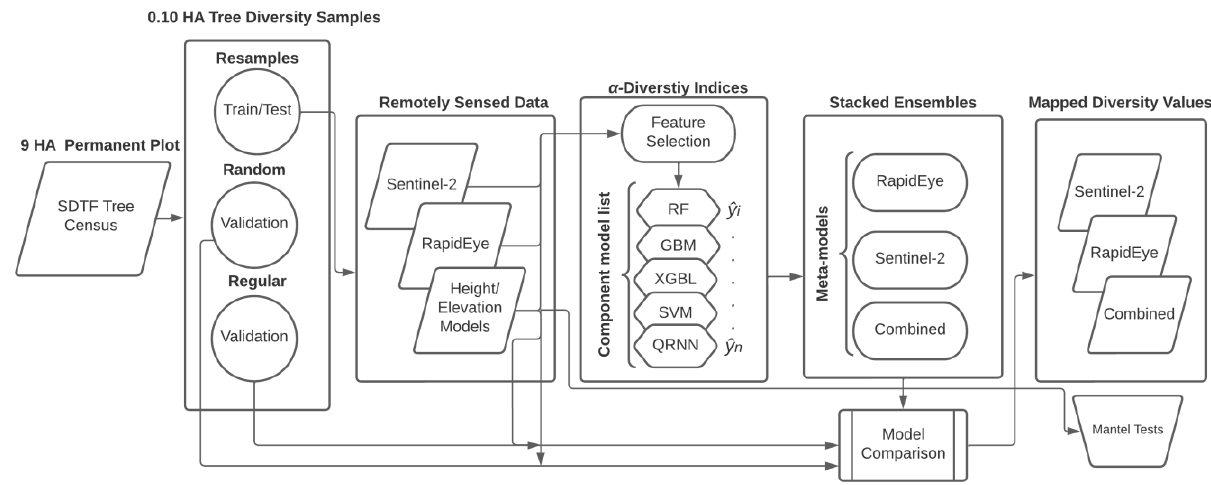
Figure 5. Workflow for data and ensemble model development, assessment, and comparison.